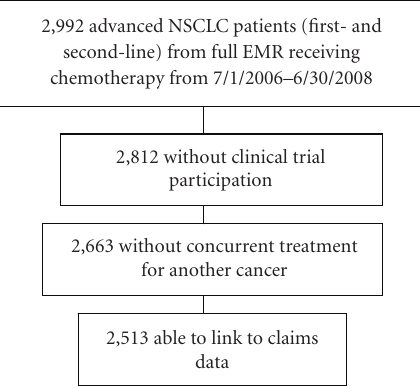
Figure 1: Sample selection flow chart. Abbreviations: EMR: electronic medical record. NSCLC: non-small cell lung